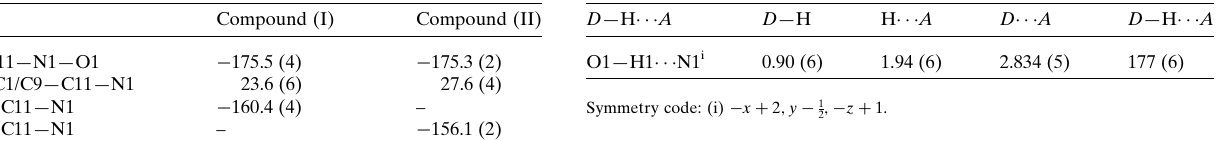
Table 1 Selected torsion angles ( (cid:2) ) for the aldoxime groups in (I) and (II).